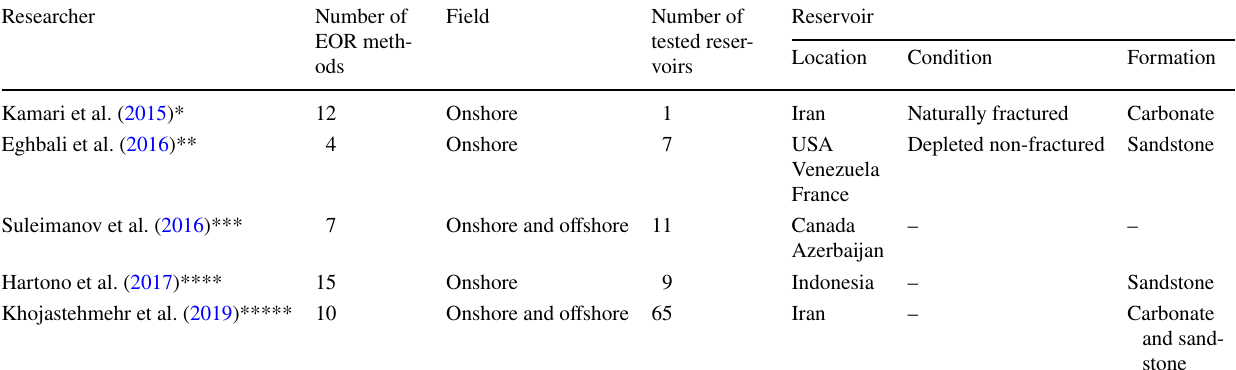
Table 2 EOR screening studies